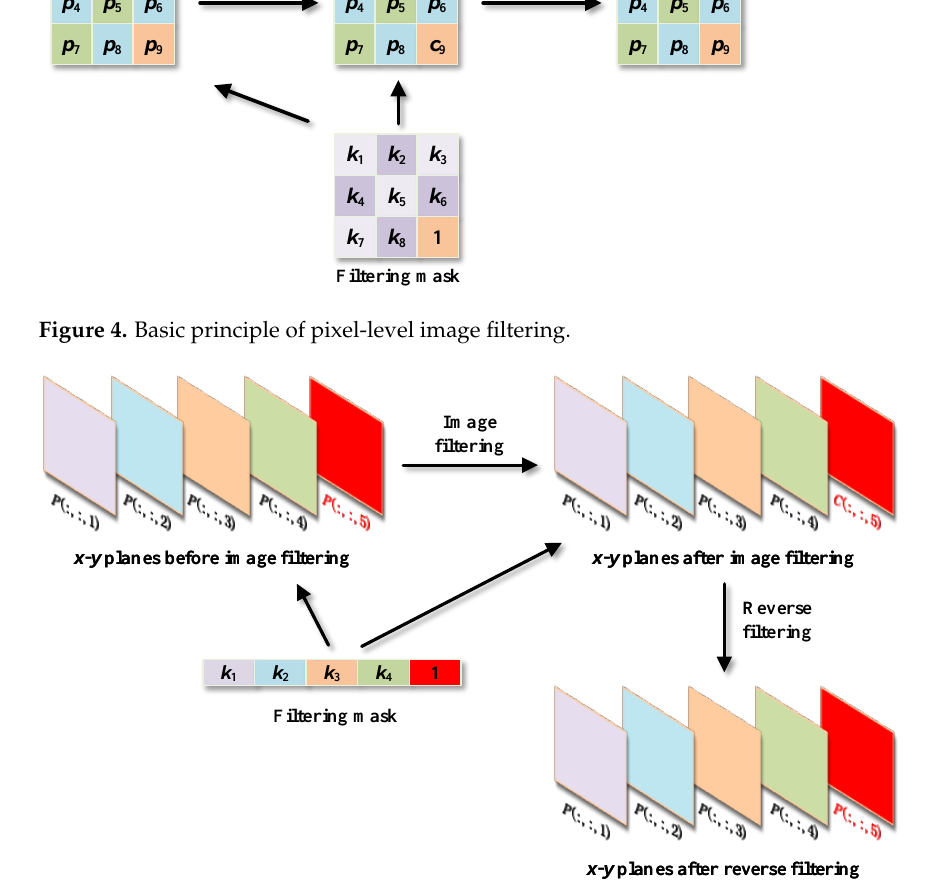
Figure 5. An example of plane-level image